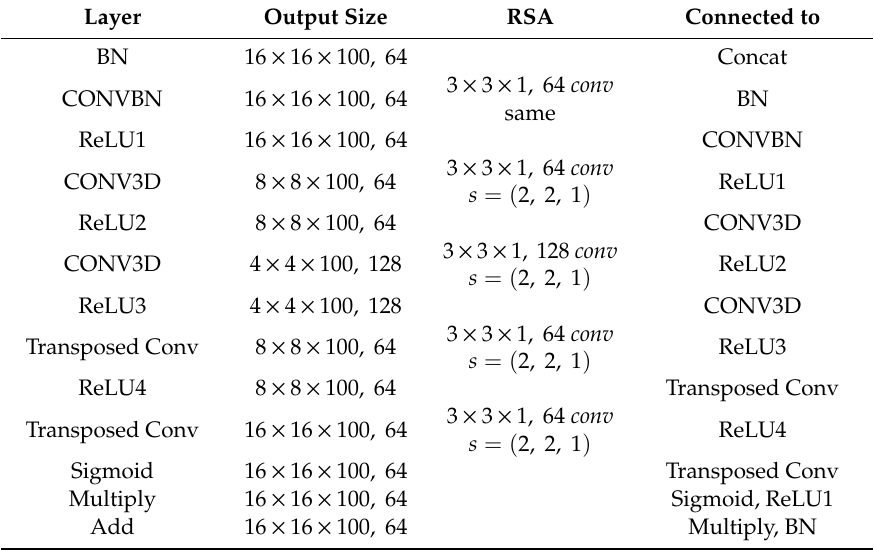
Table 3. The network configuration of the residual spatial-wise attention (RSA)